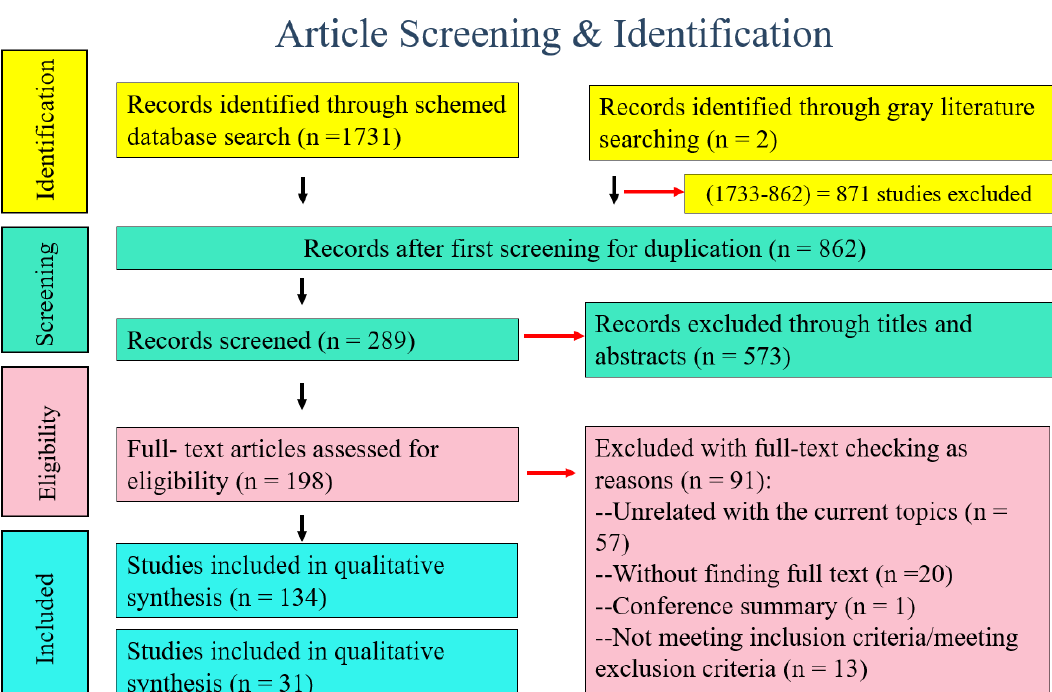
Figure 1. Flow diagram of literature screening and identification strategy.